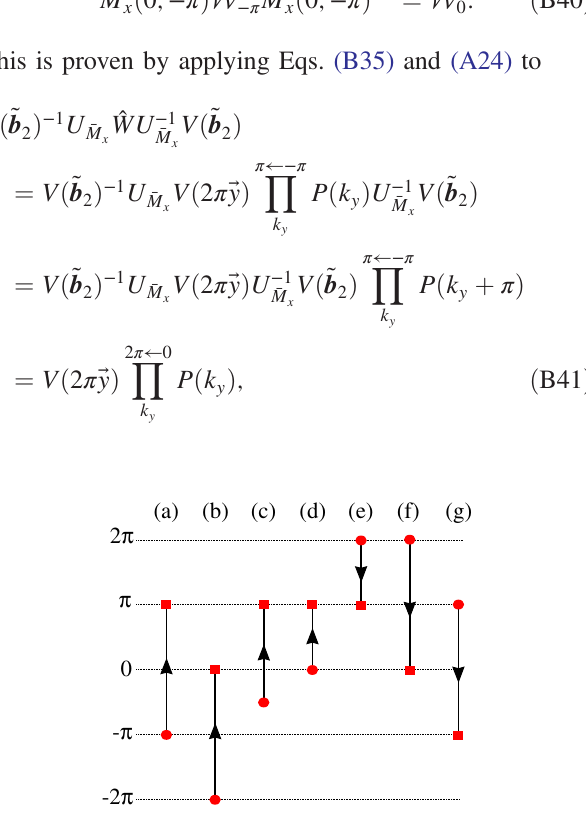
. = 2 , e.g., W y r; 2 π